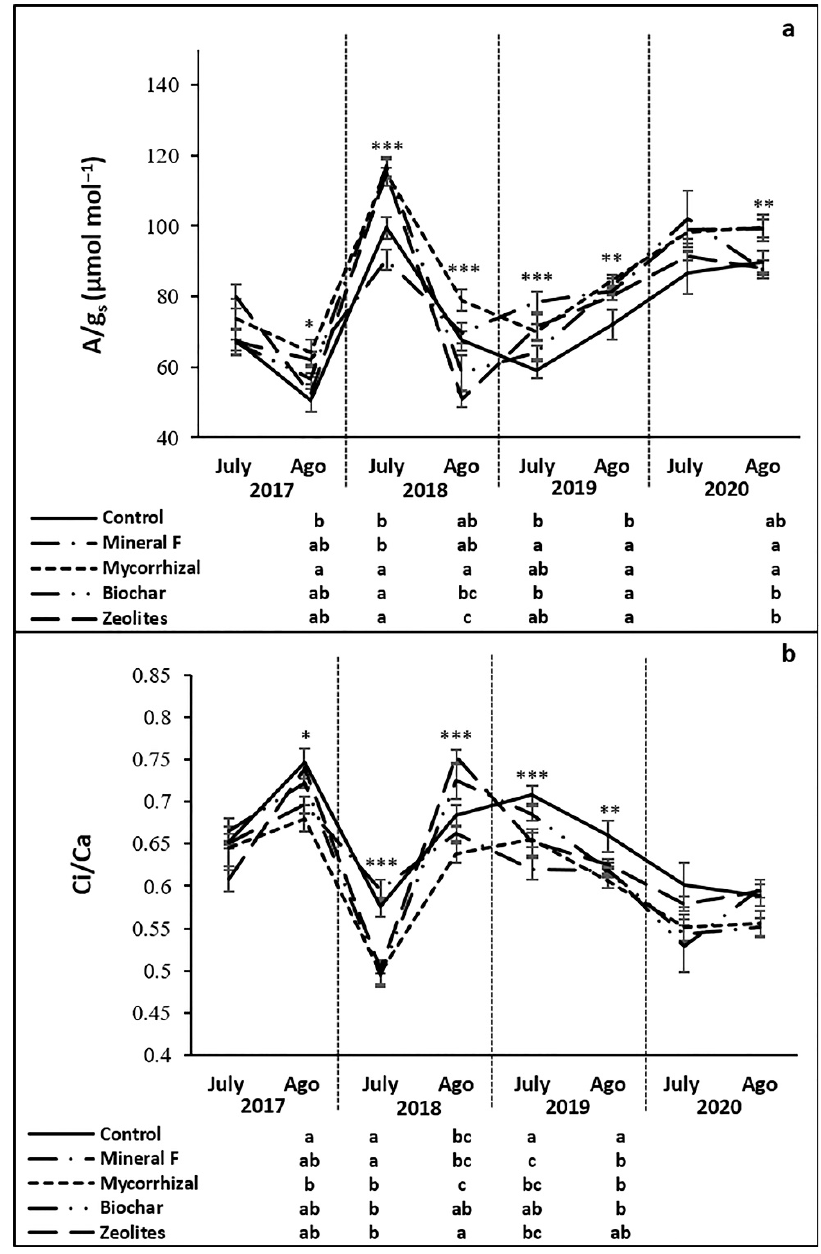
Figure 5. Evolution of intrinsic water use efficiency ( a ) and the ratio of intercellular to atmospheric CO 2 concentration ( b ) throughout the experiment. Different letters demonstrate significant differences by Tukey HSD test ( p < 0.05) between treatments in each date. Vertical bars are the standard errors; * ( p < 0.05), ** ( p < 0.01) and *** ( p < 0.001) are the results of analysis of variance.